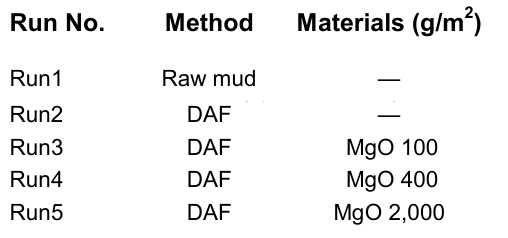
Cultural Condition in Experiment Run